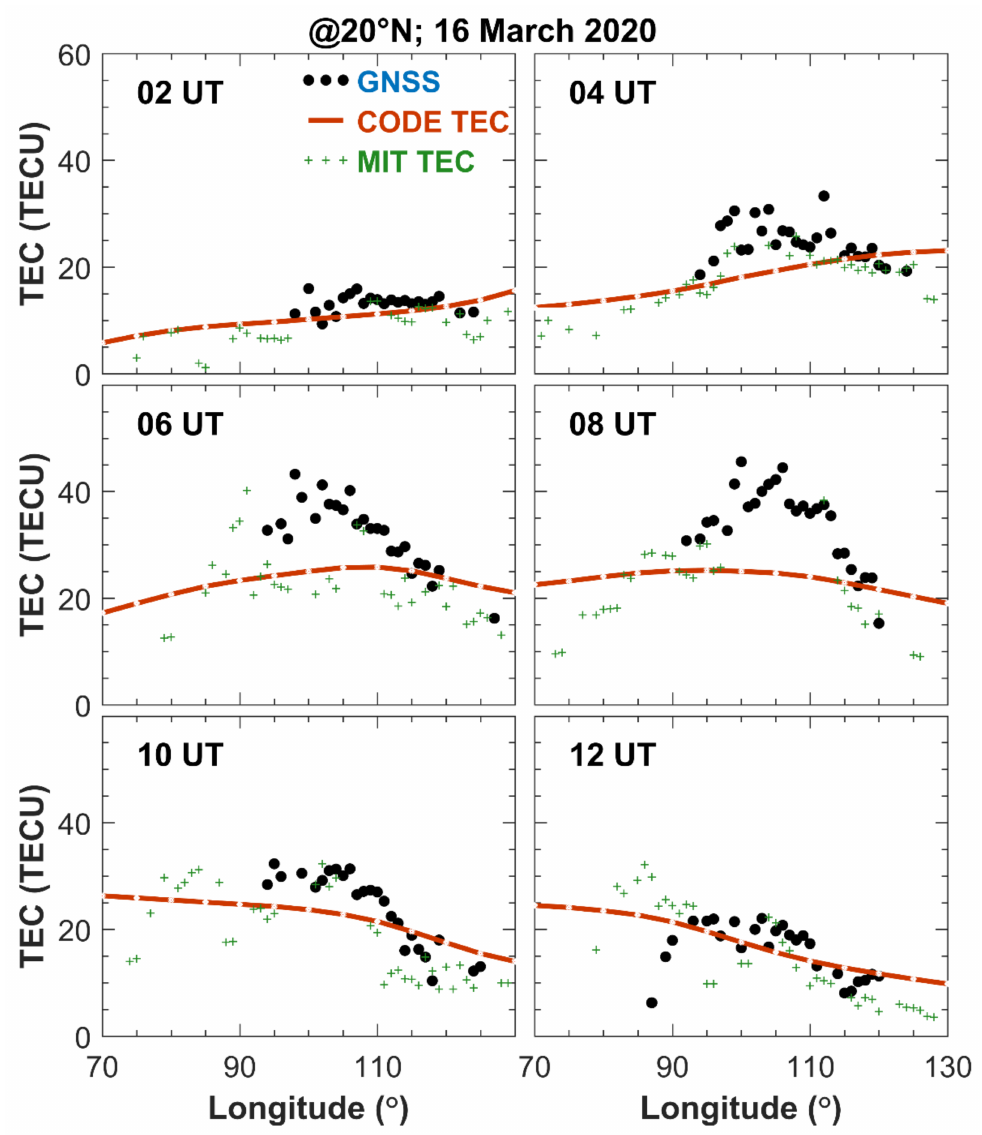
Figure 13. Same as Figure 12, but for the case on 16 March